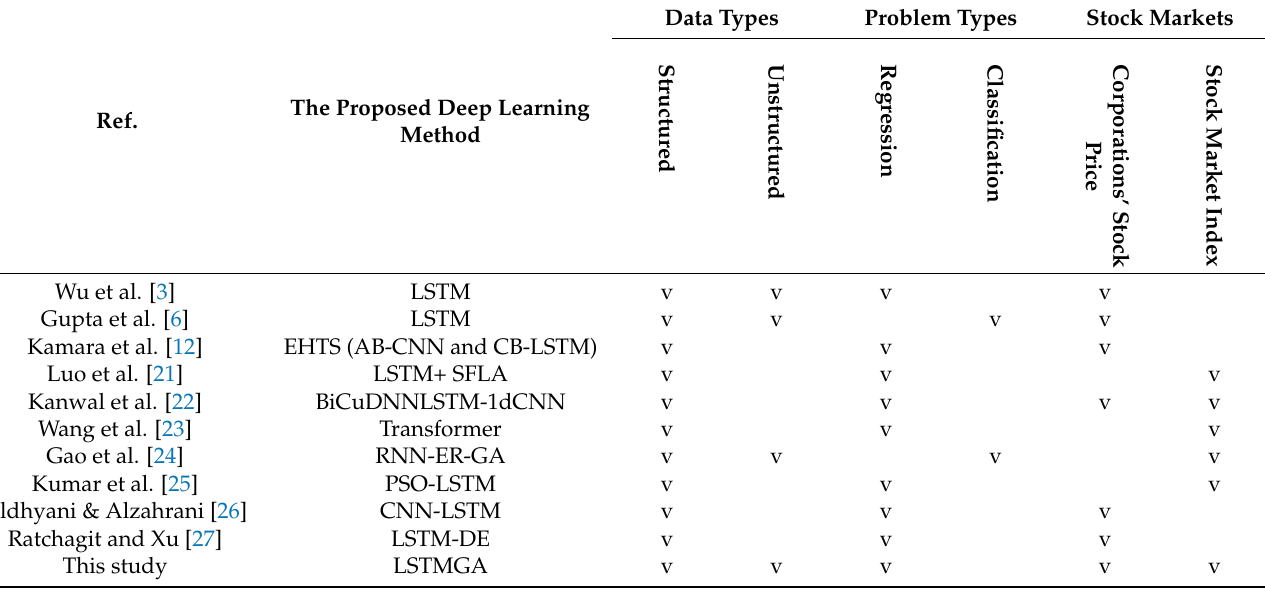
Table 1. The summary of recent literature in 2022 and the proposed LSTMGA model in data types, problem types, and stock